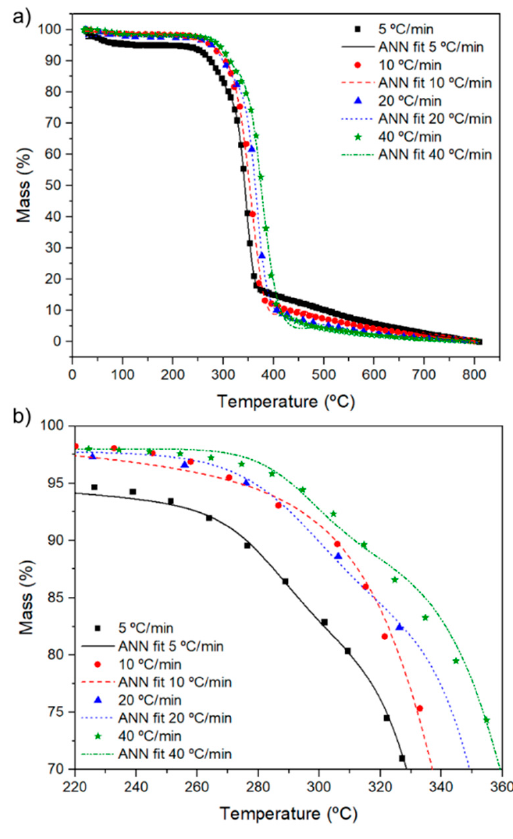
Figure 4. ( a ) Thermogravimetric curves of curaua fiber at different heating rates trained using ANN approach according to Monticeli et al. [12], and ( b ) enlargement of initial degradation.